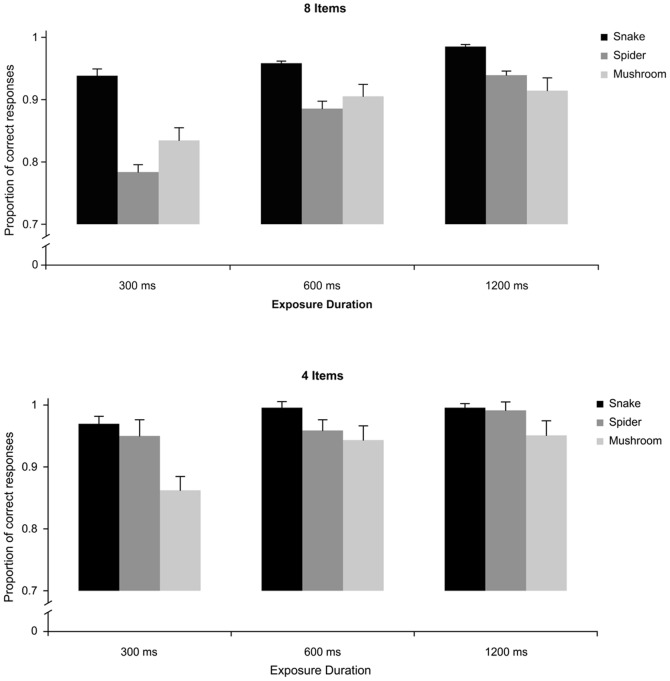
Experiment 1: Mean accuracy proportions to locate a discrepant target stimulus that could be a Snake, a Spider, or a Mushroom, in displays exposed for 300 ms, 600 ms, and 1200 ms that included eight (a) or four items (b).